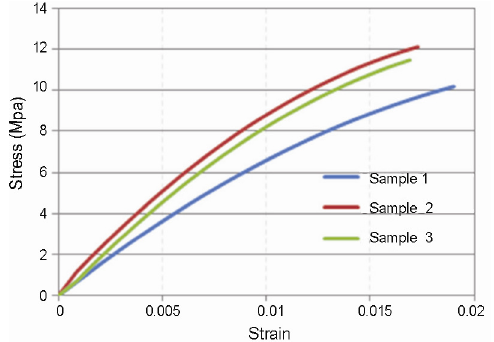
Fig. 3. Experimental tensile stress–strain relationships of WPC samples Table 1. Material parameters and mechanical properties of